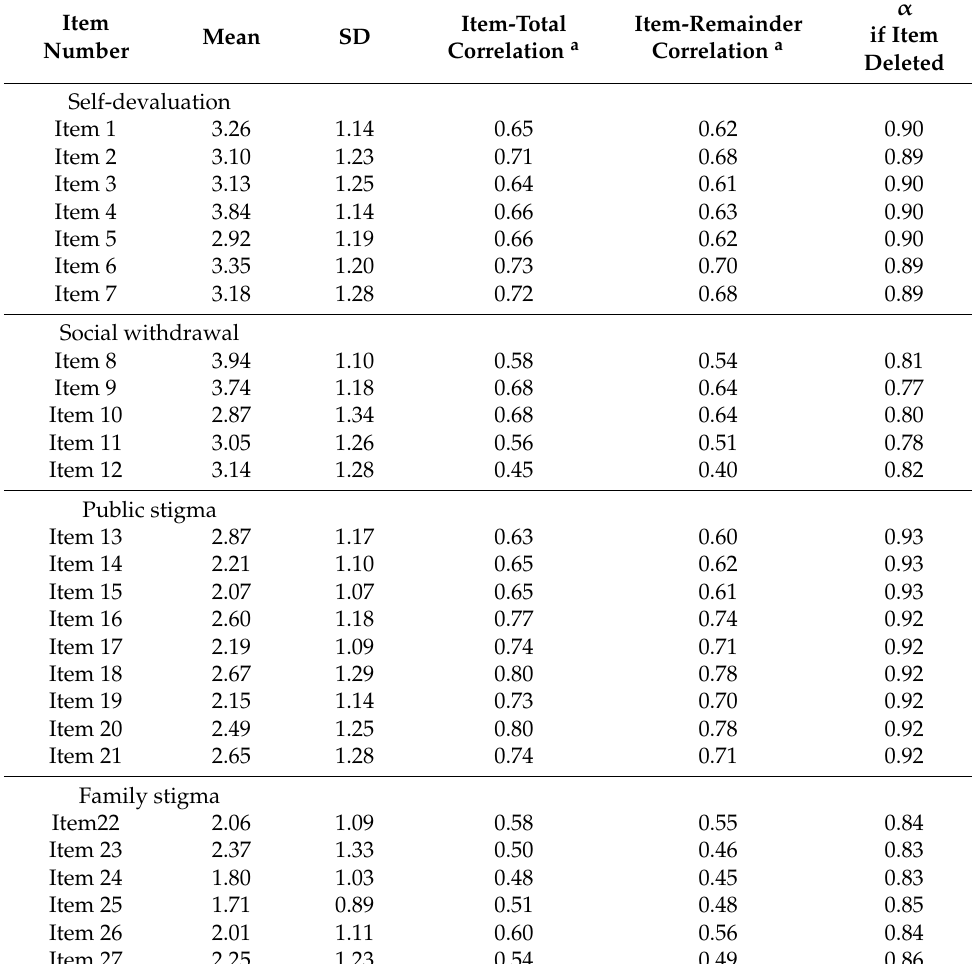
Table 4. Internal consistency of the ISS ( N = 254).